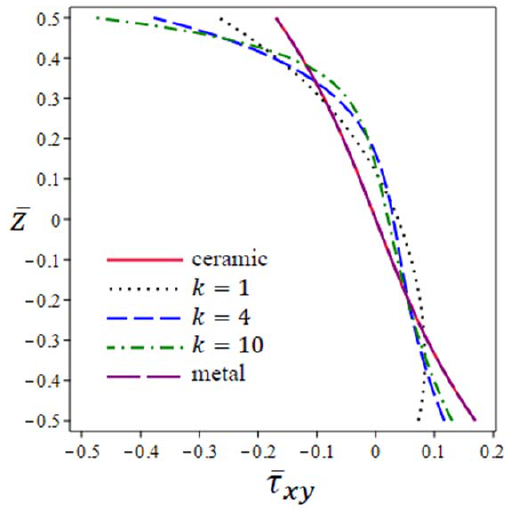
Figure 12: The in-plane tangential stress across the thickness of a FG